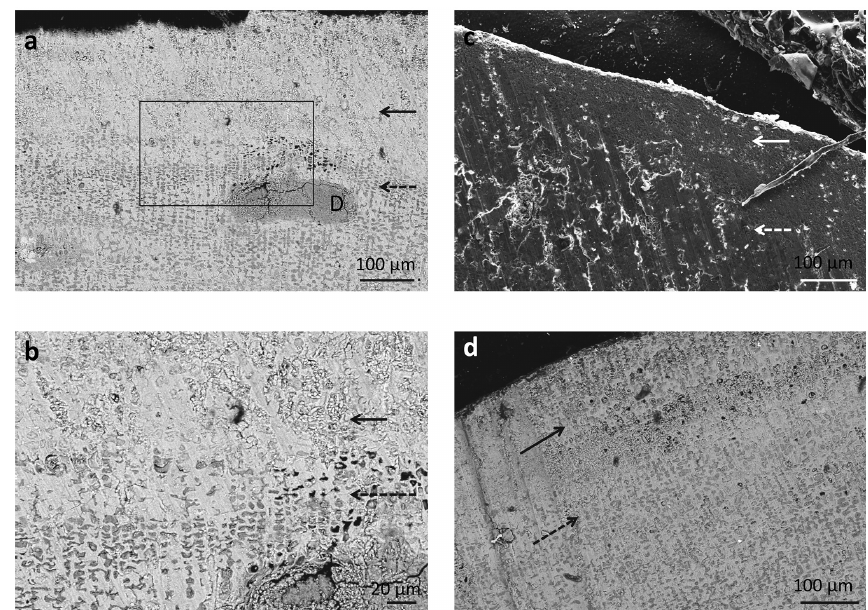
Figure 5. Control P. onkodes with experimental growth on pre-experimental growth. (a) (BSE) There is a visible difference in the appearance of experimental crust (black arrow) to the pre-experimental growth (black dashed arrow). The lighter grey of the surface is due to less magnesium (dolomite) infilling the cells that appear as darker grey infill in the pre-experimental lower part of the crust. Black box enlarged in (b) . D is dolomitised conceptacle. (b) Close up showing the consistent presence of infill in pre-experimental growth whereas in the new growth regular dolomite cell lining is absent. Also, the Mg-C crust itself appears to be less dense with many cracks from the cutting visible in the new growth but not so in the pre-experimental growth. (c) Secondary electron image of control CCA. The pre-experimental growth appears to have a fine opaque organic film covering part of the cut crust (white dashed arrow), but this is not present in the experimental growth (White arrow). (d) Control CCA (BSE) Dashed arrow to pre-experimental growth. Grey cells are dolomite infill. Black arrow to experimental growth, generally an absence of dolomite infill, note line of porosity in transition between pre-experimental and experimental growth. Scale bars: (a) , (c) and (d) = 100 microns, (b) = 20